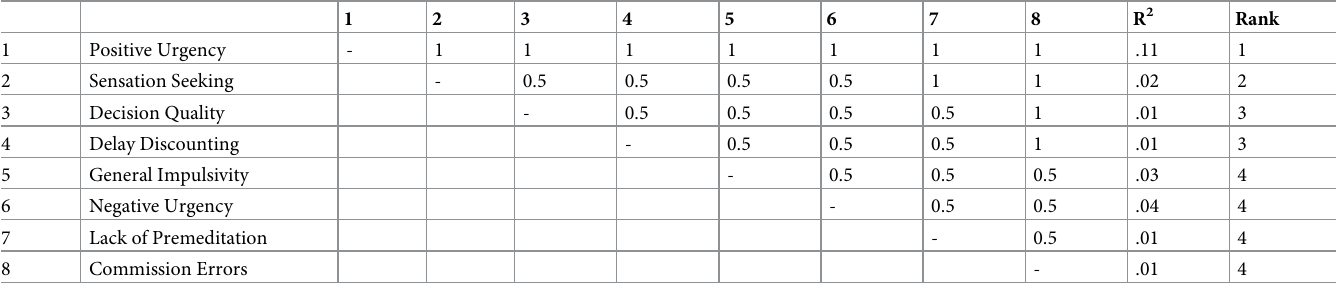
Table 9. Dominance matrix for Model 4 predicting the antisocial facet arranged by order of complete dominance.